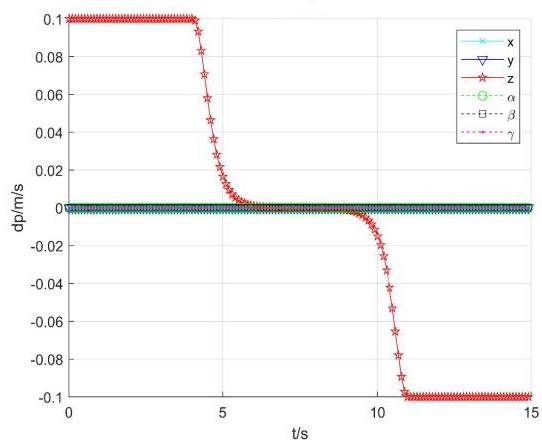
Figure 14. Velocity variation of robot joints.